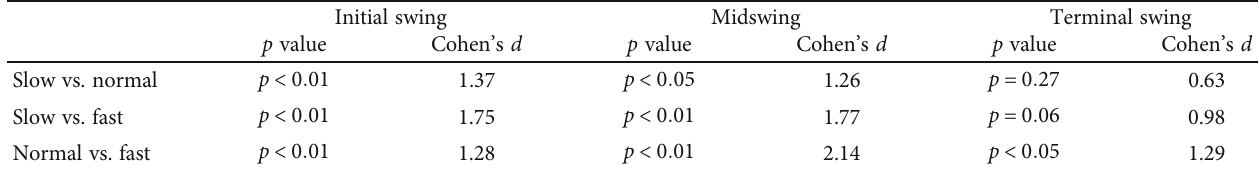
Table 3: Statistical results of post hoc test of margin among the conditions of walking speed by phase. Initial swing Midswing Terminal